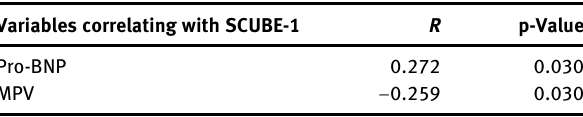
Table  : Correlation coef fi cients with SCUBE-  . Variables correlating with SCUBE-